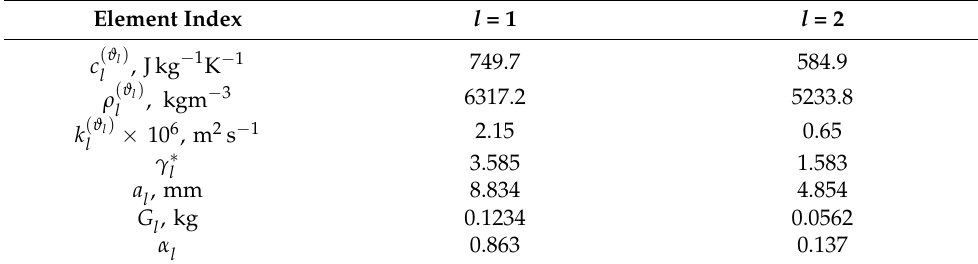
Table 5. Calculated parameters at volume temperature ϑ l , l =